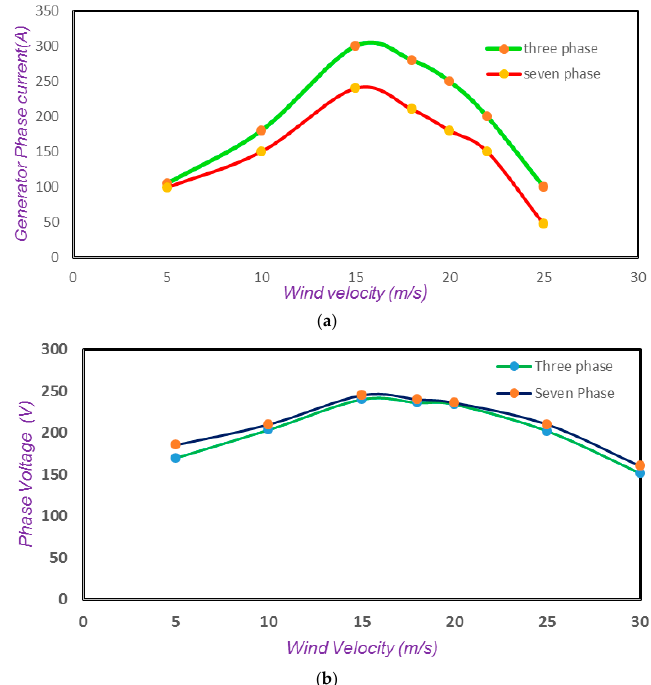
Figure 11. ( a ) Seven Phase Current vs. Three Phase Current for Varying Wind Velocity; ( b ) Three Phase Voltage vs. Seven Phase Voltage.